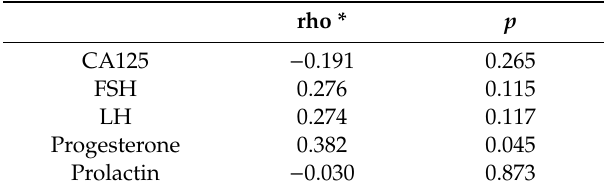
Table 2. Correlation between hormone levels and BICR5 expression in peripheral blood of women with